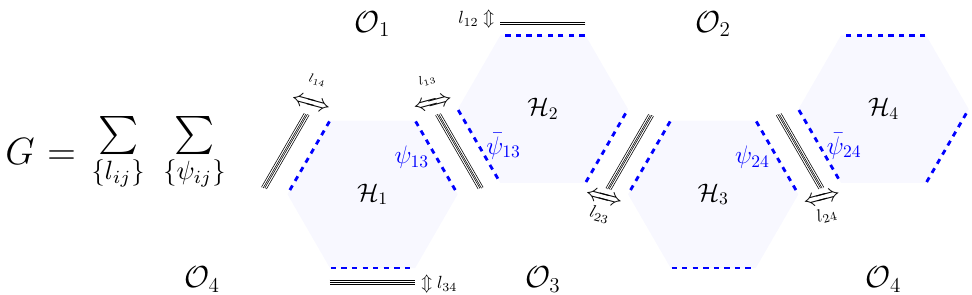
Figure 11 . Hexagonalization: finite-coupling correlators are obtained from the sum over the free theory graphs (skeleton graphs) labeled by the six bridges { l which are glued by sums over complete basis of mirror states { ψ H ψ ij ,ψ jk ,ψ ki traversing the bridges. The unrestricted sum over all non-negative integers l four-point planar